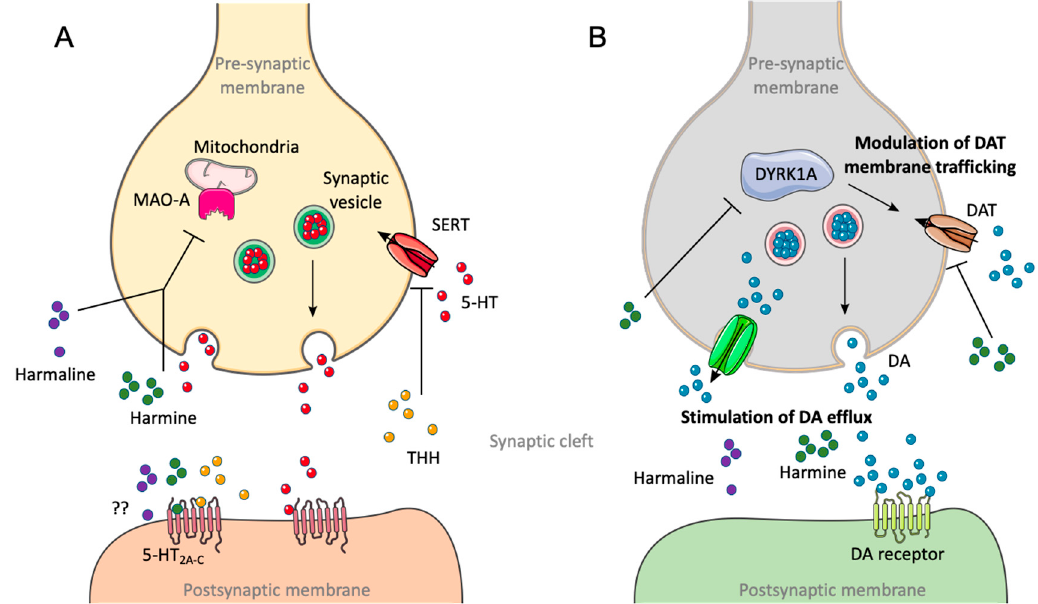
Figure 5. Pharmacodynamic mechanisms of harmine, harmaline, and tetrahydroharmine (THH) at the serotonin (5-HT) ( A ), and dopamine (DA) ( B ) pathways. DAT: DA transporter; DYRK1A: Tyrosine-phosphorylation-regulated kinase 1A; MAO-A: Monoamine oxidase A; SERT: 5-HT transporter.